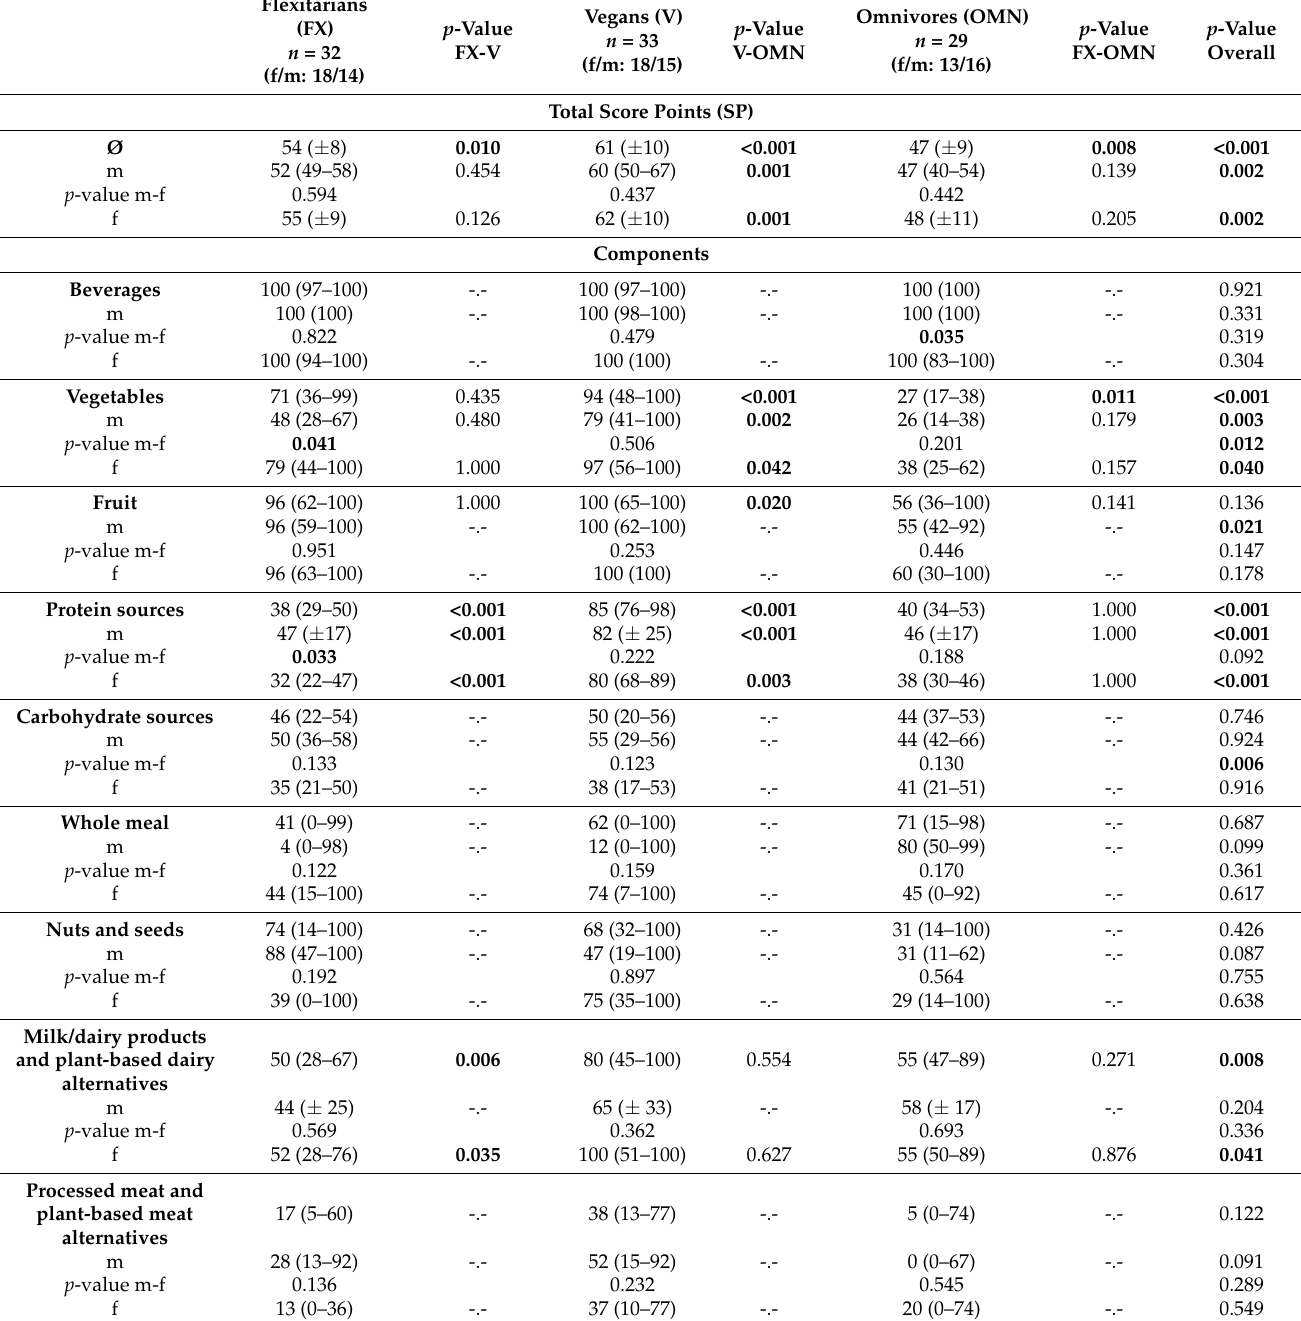
Table 3. Total score results by diet type and